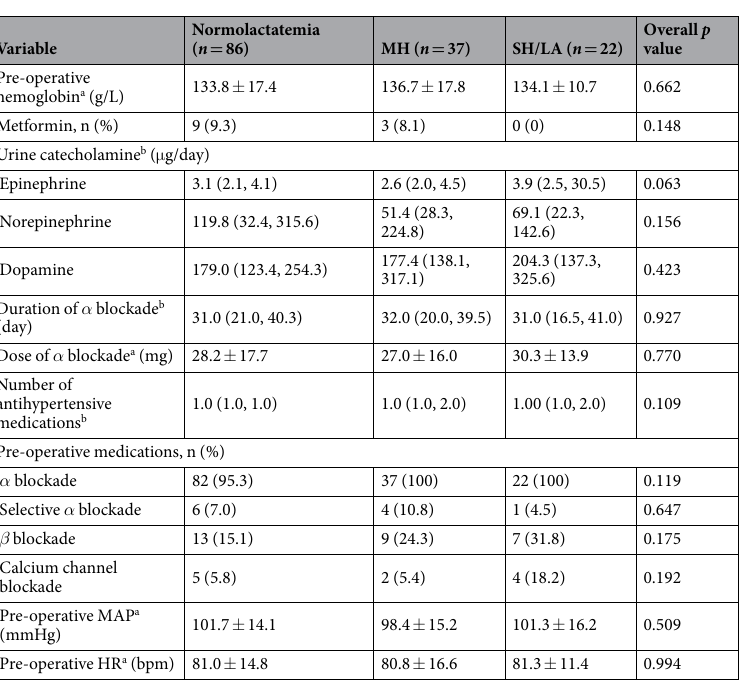
Table 2. Pre-operative data. MH, moderate hyperlactatemia; SH/LA, severe hyperlactatemia/lactic acidosis; MAP, mean arterial blood pressure; HR, heart rate. * p < 0.05 vs the normolactatemia group. a Mean ± standard deviation; b median (25th percentile, 75th